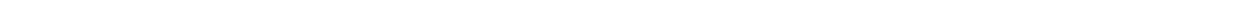
Fig. 4 Conformational changes observed in complexes representing steps in JMJD5 catalysis. a Proposed mechanism of JMJD5-catalysed (3 R )-Arg- hydroxylation (reactive intermediates in parentheses), b JMJD5.Mn.2OG, c JMJD5.Mn.NOG.RCCD1(139-142) (Complex 3), d JMJD5.Mn.succinate.RCCD1 (2 S ,3 R -OH) (product) modelled complex, e JMJD5.Mn.succinate and f apo-JMJD5. The fi gure illustrates global and local changes occurring on substrate/ cosubstrate binding and product release, which is a characteristic feature of JMJD5 catalysis. Two mobile regions are involved in JMJD5 catalysis: (i) the β 3 – β 4 loop (N-terminal to the DSBH, aa 234 – 254, raspberry to cream), and (ii) the DSBH β IV – β V loop (aa 342 – 381, different blue shades). Analogous loops are often involved in substrate binding by other JmjC-hydroxylases and KDMs, including FIH 37 , RIOX 30 , KDM4A 57,58 and PHF8 59 . The β 3- β 4 loop, which is often relatively short as in some KDMs, is 'open' in the JMJD5.Mn.2OG-, 'partly open' in the substrate-, and disordered in the succinate- complexes. In all JMJD5 structures, except for apo-JMJD5, the β IV – β V loop adopts a similar conformation (i.e., partly helical); however, in the apo structure, part of β IV – β V loop (aa 351 – 361) adopts a hairpin conformation. Note the conformational changes in the sidechains of active site residues involved in catalysis. The JMJD5.Mn.succinate.RCCD1 (2 S ,3 R -OH) complex was modelled using the JMJD5(N308C).RCCD1 (Complex 3) and JMJD5. succinate structures as